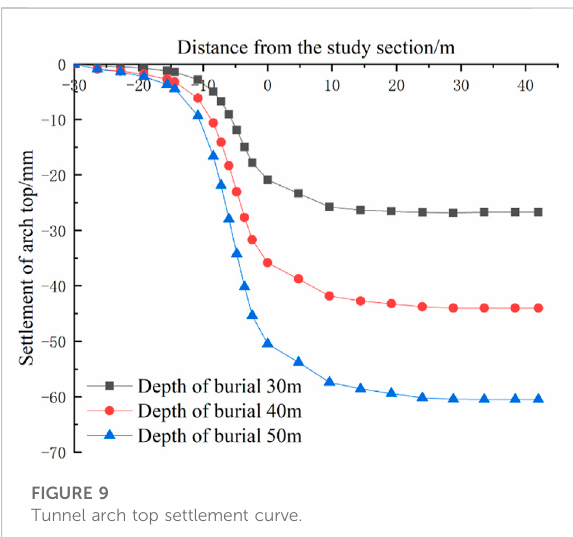
FIGURE 9 Tunnel arch top settlement